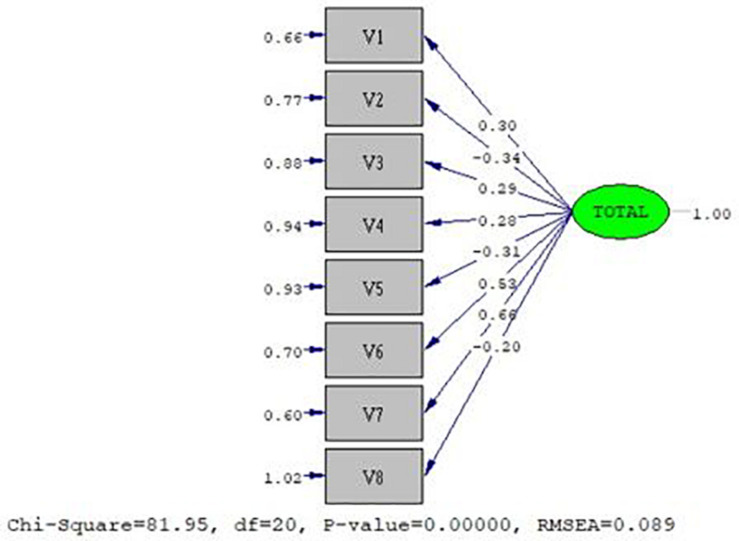
Representation of the best fit model.